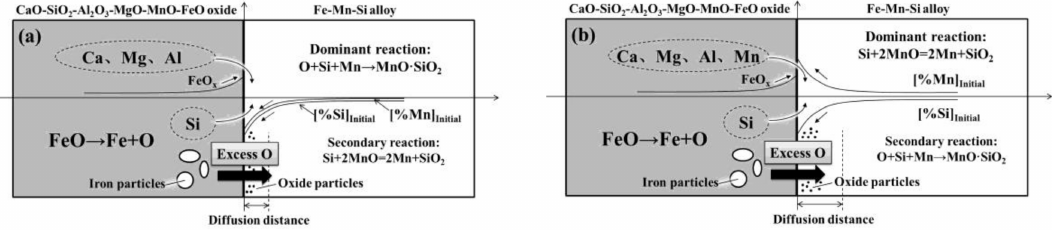
Figure 11. Illustration of the interfacial reaction mechanism between the Fe–Mn–Si alloy and CaO–SiO 2 –Al 2 O 3 –MgO–MnO–FeO oxide during isothermal heating: ( a ) A-1-1, A-1-2 and A-1-3; ( b ) A-1-0 and A-2- x